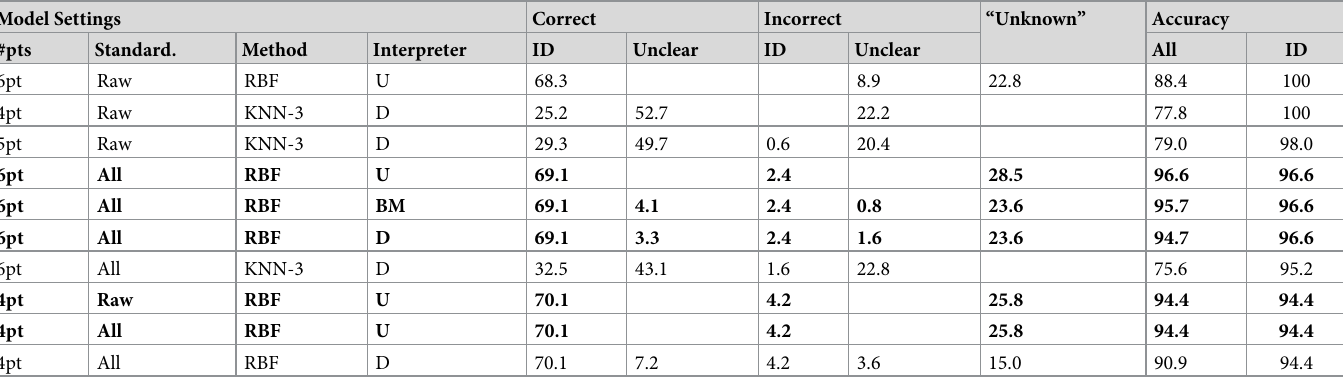
Bold Models are shared with Table 4. Numbers represent percentages. For Interpreter, U is defined as “Unanimous”, BM as “Best Match”, and D as